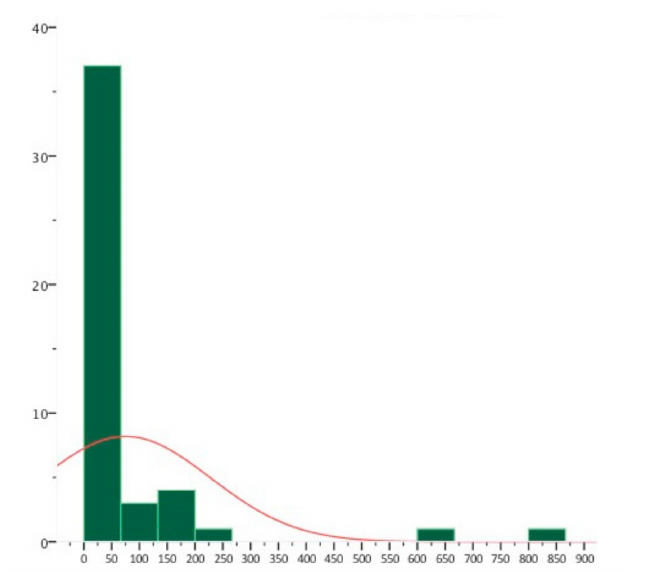
Figure 2. Duration of seizures (x axis, duration of seizures in seconds; y-axis, number of seizures). According to the EEG morphology and amplitude at seizure onset, rhythmic ictal discharge of >20 µ V was the most common category at seizure onset (n = 21), followed by a low amplitude beta ictal rhythm (<20 µ V) (n = 14). The location and